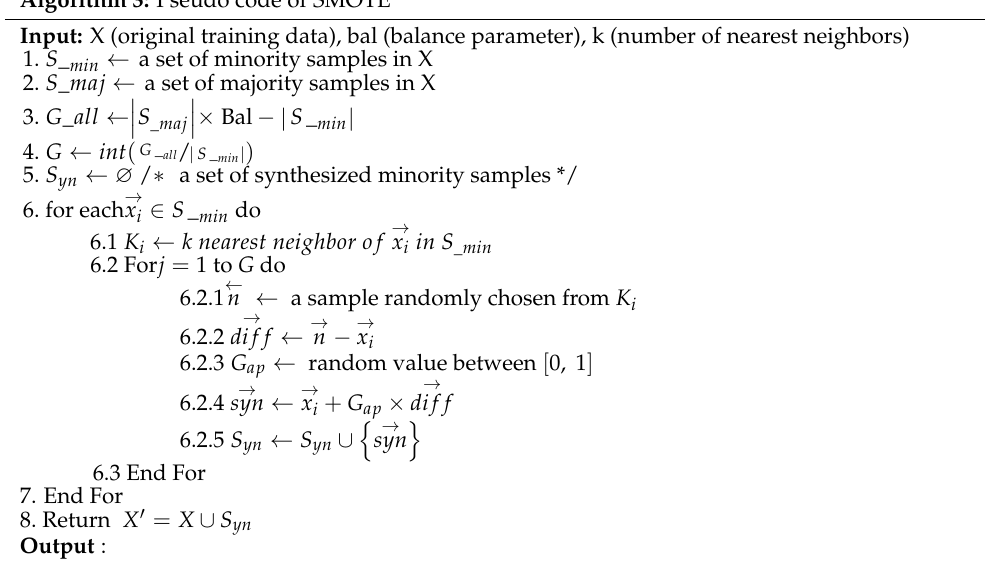
Algorithm 3: Pseudo code of SMOTE